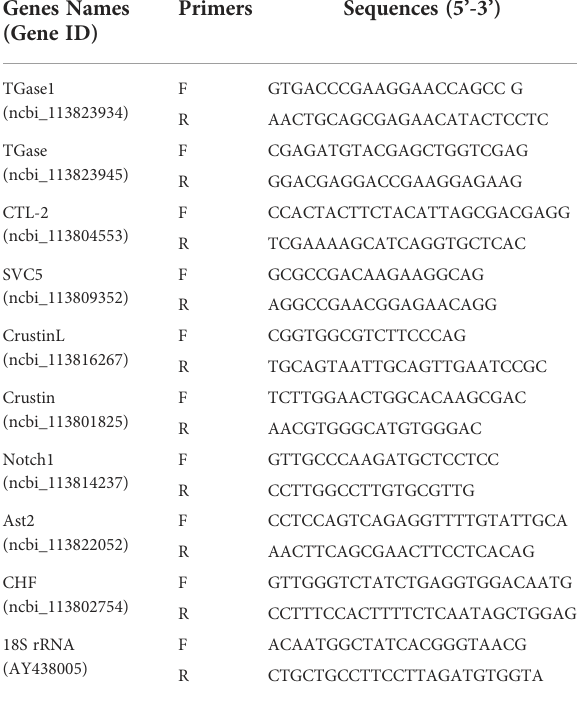
TABLE 2 Primers used in qPCR of this study, related to Figure 6